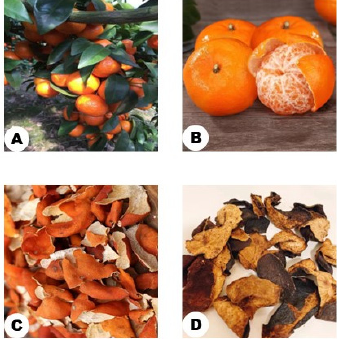
Figure 1. ( A ) Citrus reticulata Blanco tree ( B ) fresh ripe citrus ( C ) fresh mature pericarps ( D )